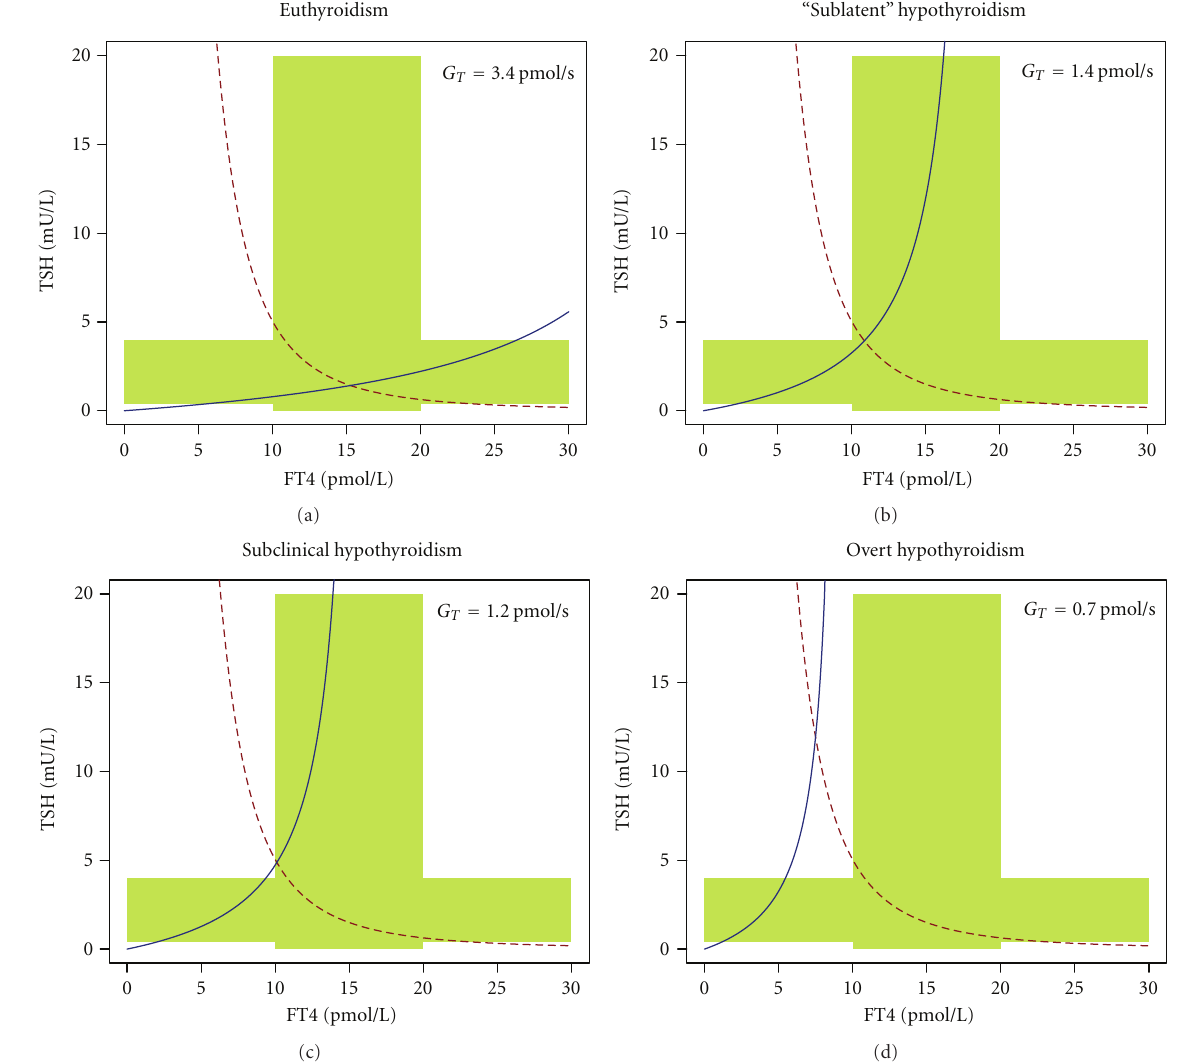
Figure 5: Successive development of hypothyroidism as a consequence of decreasing G T . Beginning with a hypothetical “sublatent” form defined by reduced G T and still normal levels of TSH and FT4 (panel b), further steps are subclinical hypothyroidism with increased TSH levels and FT4 still in the lowest fraction of the reference region (panel c) and overt hypothyroidism where both parameters have left their reference region (panel d). See text for additional